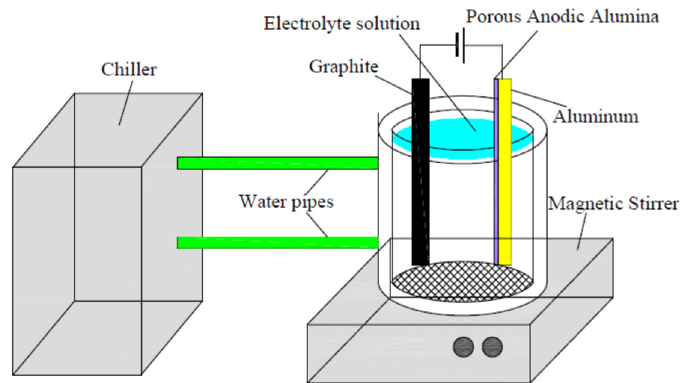
Figure 4. Schematic drawing of the anodizing